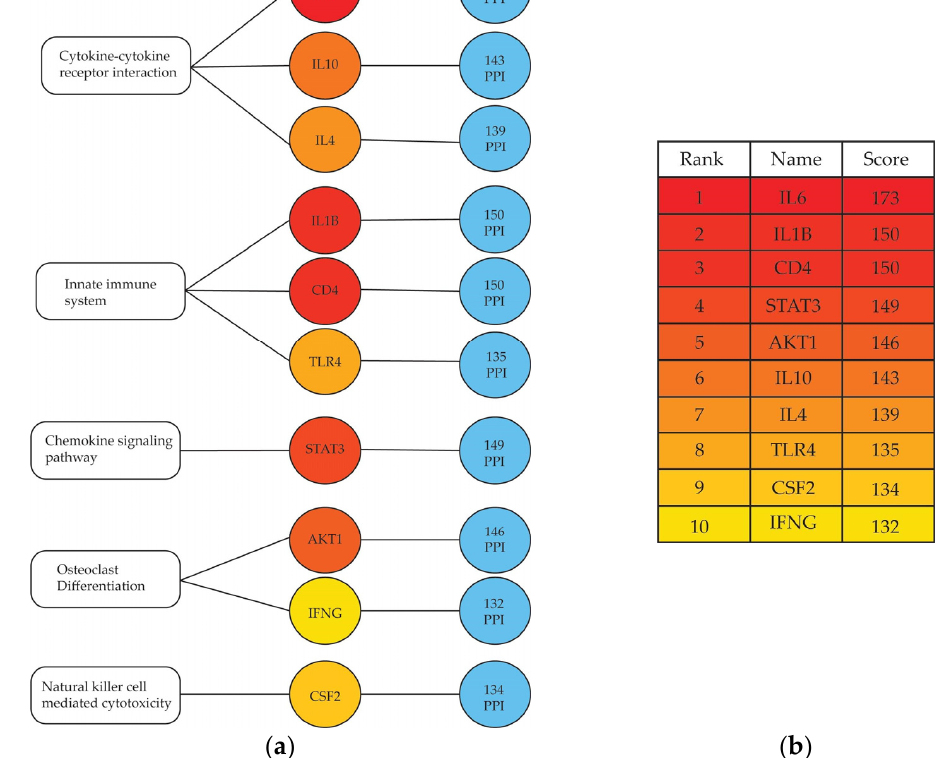
Figure 2. Top 10 hub proteins and their PPI rankings by degrees method. The 10 most-connected DEGs were identified as central hubs using cytoHubba based on their degrees of interactions with other genes/proteins. ( a ) Hub genes mapped back to five significantly impacted pathways, and the number of protein–protein interactions (PPI) for each are listed in blue circles. The proteins and their rank-by-degree scores are represented by a red-yellow color gradient. Red indicates the highest degree score, orange is intermediate, and yellow indicates the lowest; ( b ) Table of hub genes ranked by their degree score (PPI) using the same color gradient. Table 4. List of top 10 drug targets.